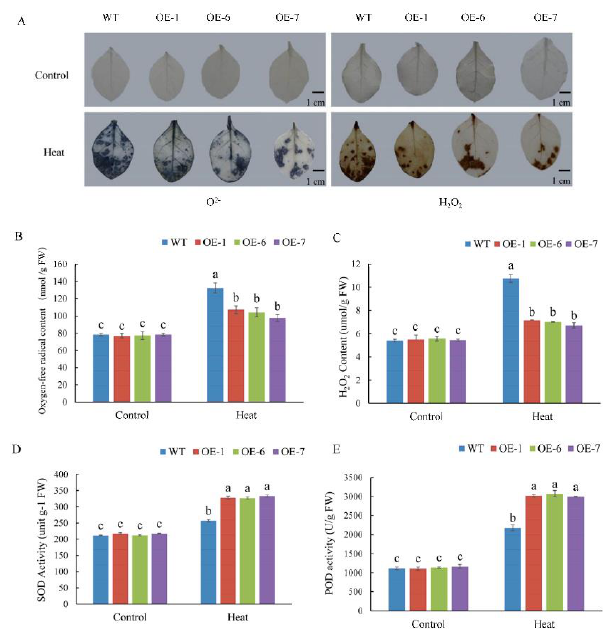
Figure 9. Overexpression of MdPRP6 alleviated oxidative damage in tobacco under heat stress. ( A ) DAB and NBT staining. ( B ) O 2− concentrations; ( C ) H 2 O 2 concentrations; ( D ) Activities of superoxide dismutase (SOD), and ( E ) activities of peroxidase (POD). Scale bar = 1 cm. Data are means of